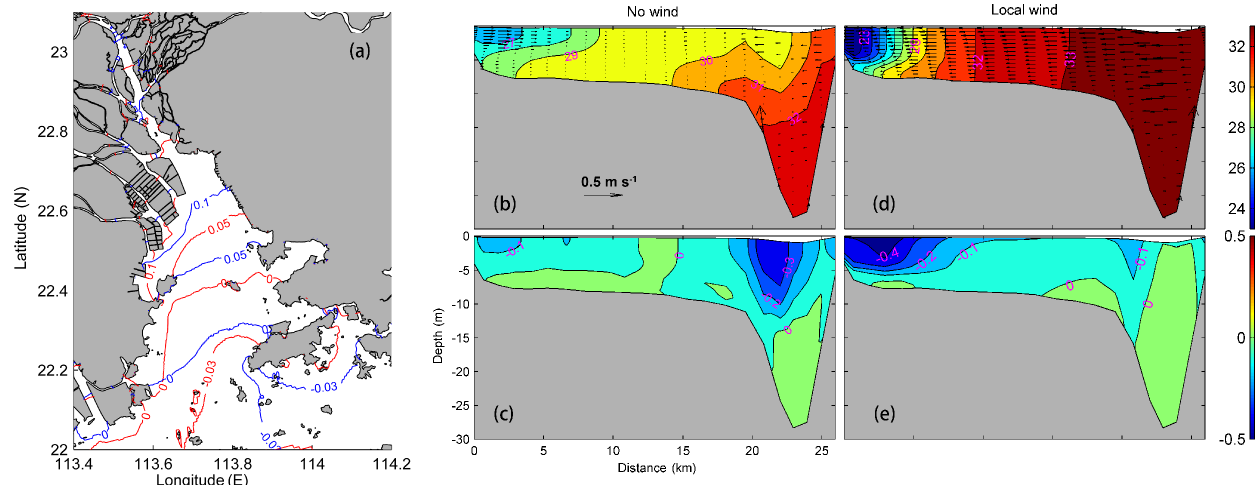
Figure 8. Comparison of subtidal water level during the spring tide for Cases 1 and 2. Panel (a) the blue line depicts Case 1, while the red line represents Case 2 (units: m) and comparison of 50h averaged salinity (units: ppt) and current (units: ms − 1 ) at the estuary mouth (T2) for Cases 1 and 2; panel (b) the salinity and lateral flow in Case 1; panel (c) the axial current in Case 1; panel (d) the salinity and lateral flow in Case 2; panel (e) the axial current in Case 2. The negative values in panels (d) and (e) mean seaward currents.